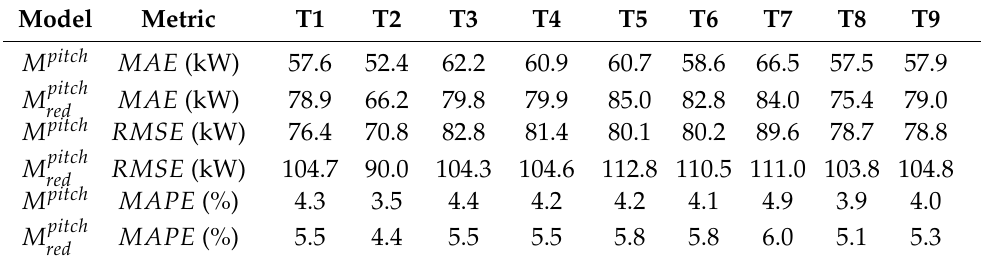
Table 10. Results of the models validation for the blade pitch—power curve in Region 2 1 / 2 : WF2. Model